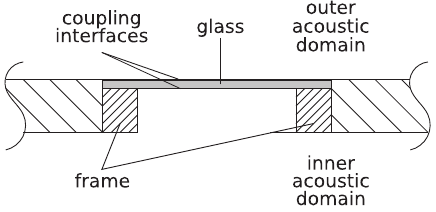
Figure 4. Schematic drawing of mechanical regions.